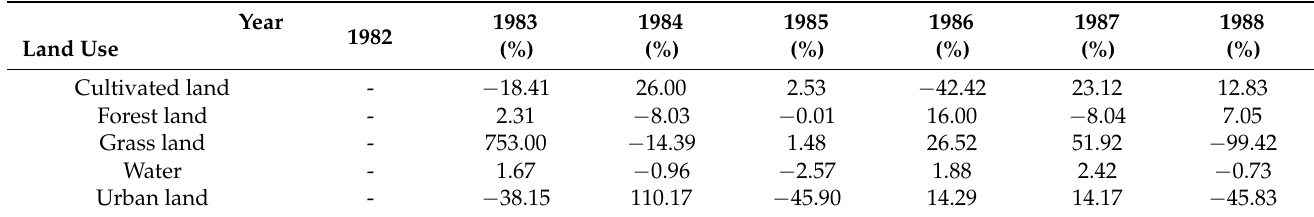
Table 1. Rate of land-use change of the study area from 1982 to